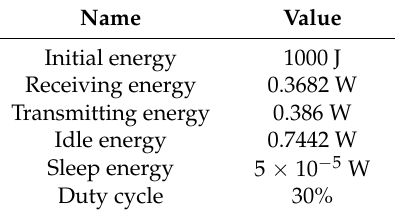
Table 2. Network parameters.